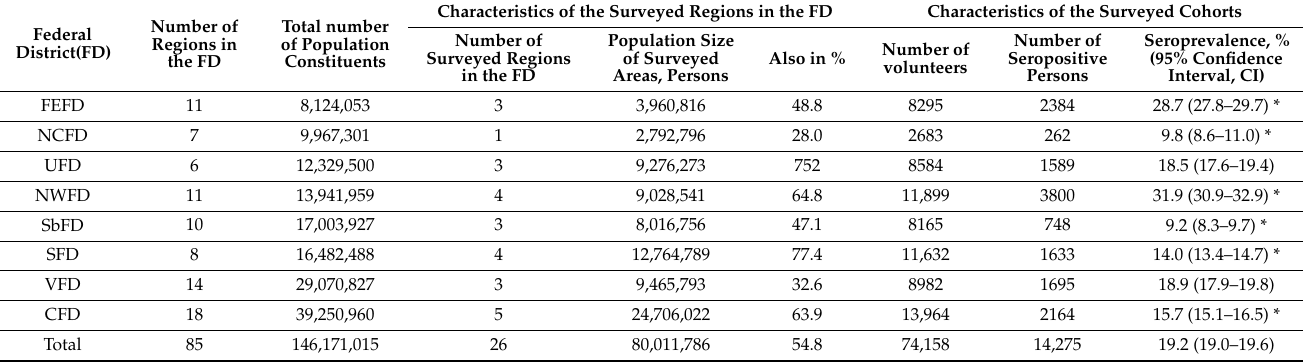
Table 1. Distribution of model regions by Russian Federal District